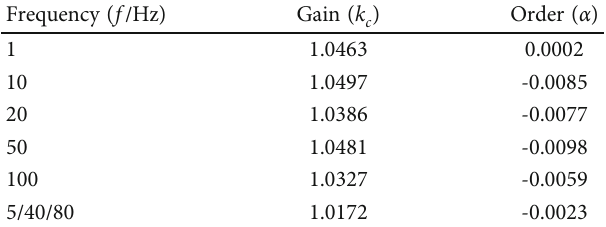
Table 1: Parameter identi fi cation result of fractional-order model.